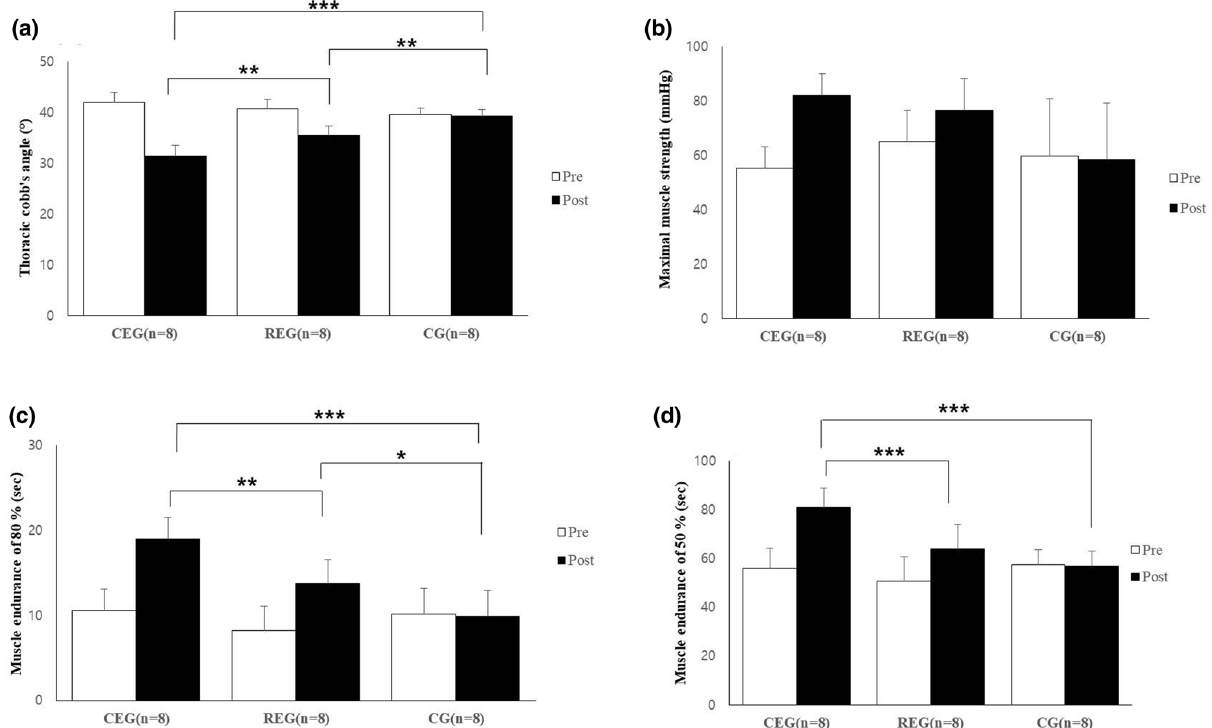
Figure 1. The difference of thoracic angle and cervical muscles strength and endurance after intervention. ( a ) Thoracic Cobb’s angle; ( b ) Maximal muscle strength; ( c ) Muscle endurance of 80%; ( d) Muscle endurance of 50%. CEG, corrective exercise group; REG, resistance exercise group; CG, control group. P < 0.0167*, P < 0.00167**: the results from Bonferroni